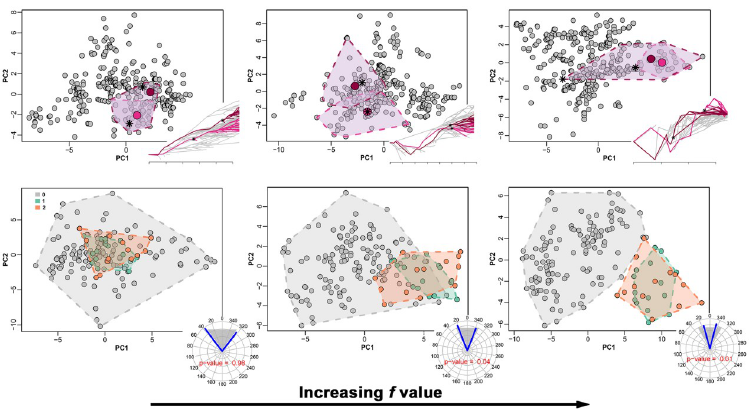
Fig 4. The effect of phenotypic similarity between clades set to converge and the rest of the tree phenotypes on seach . conv power. In each panel the PC1/PC2 plot of the tree phenotypes are reported. Clades set to converge are indicated by colored convex hulls. Upper row, clade case. Ancestral phenotypes (mrca s ) of the clades set to converge are indicated by an asterisk. Large colored dots represent the mean phenotypes (group centroids) of the clades set to converge. A modified traitgram plot is added to the lower right corner in each figure, with branches belonging to the clades set to converge highlighted in color. Lower row, species belonging to states set to converge are indicated by colored convex hulls ( 0 = background states, 1 and 2 are the states set to converge). To the lower right corner of the quadrants the circular plot reports the mean angle between states (blue lines) and the range of random angles (gray shaded area). The p-value for the convergence test is printed within the circular plots. The f values used to simulate the convergent clades are (from the left to the right): 0.2, 0.4 and